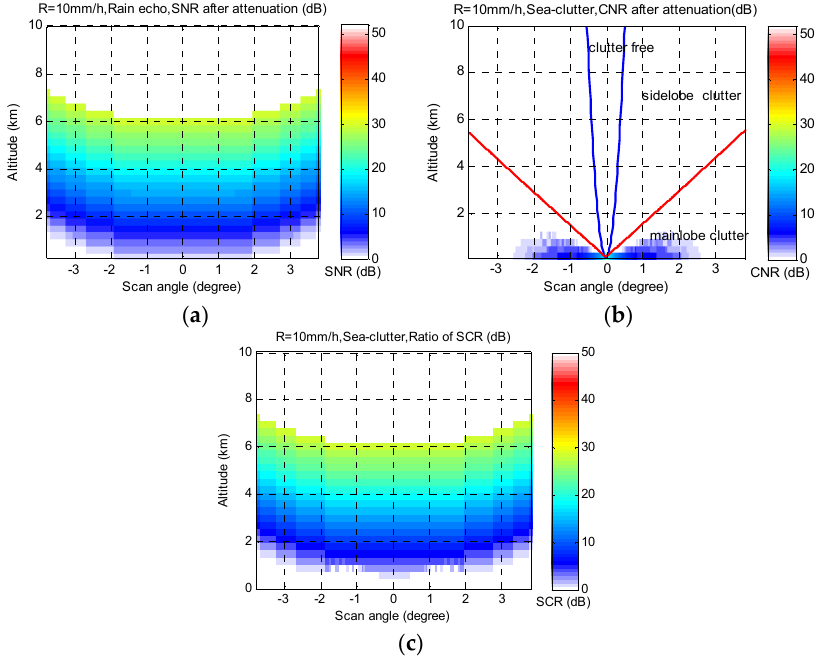
Figure 6. The power ratio of the rain echo signal to noise (SNR), the power ratio of clutter signal to noise (CNR) after rain attenuation, and the power ratio of the rain echo signal to clutter signal (SCR). A uniform stratiform rain layer is assumed with the rain top of 6 km; ( a ) SNR of rain intensity at 10 mm/h; ( b ) CNR of the sea surface; and ( c ) SCR of the sea surface greater than 0 dB.